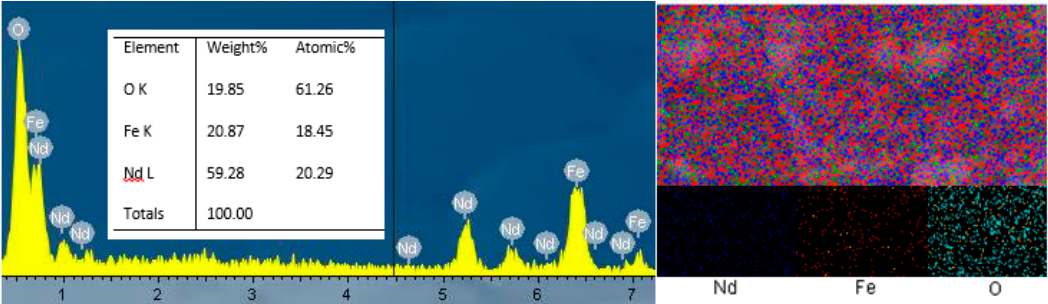
Figure 5. ( a ) SEM and ( b ) TEM images of crystalline NdFeO 3 nanoparticles annealed at 750 °C for 1 h.